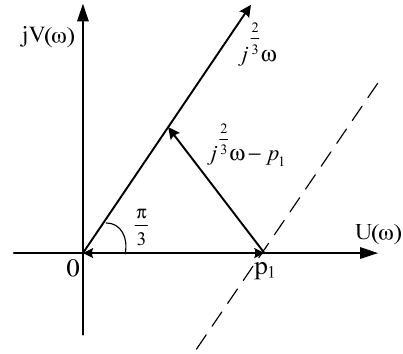
(cid:3118) (cid:3119) 𝜔 − 𝑝 (cid:2869) ) for the first root for this case provided